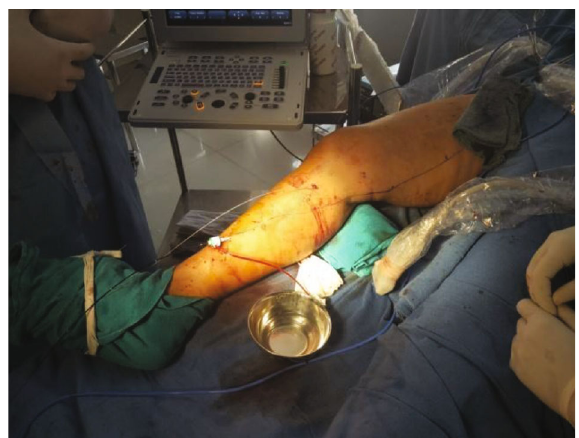
Figure 8: Double-prepuncture technique for RFA of the great saphenous vein with the tortuous segment in between two RFA catheters.